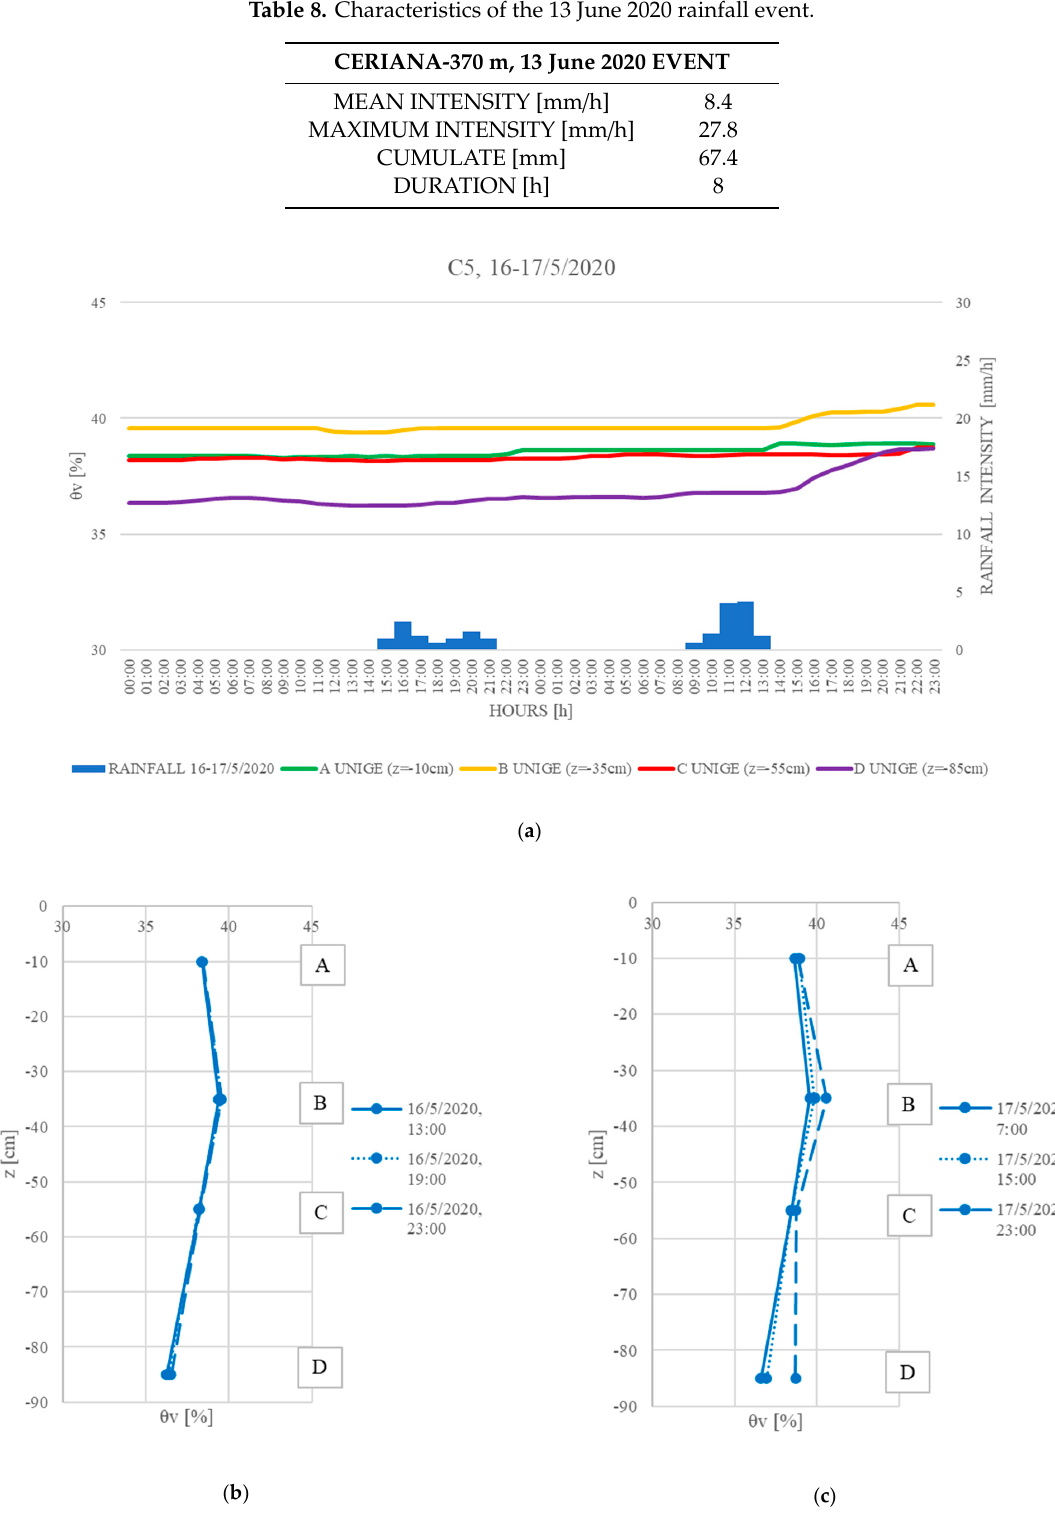
Table 7. Characteristics of the 3–4 June 2020 rainfall events.